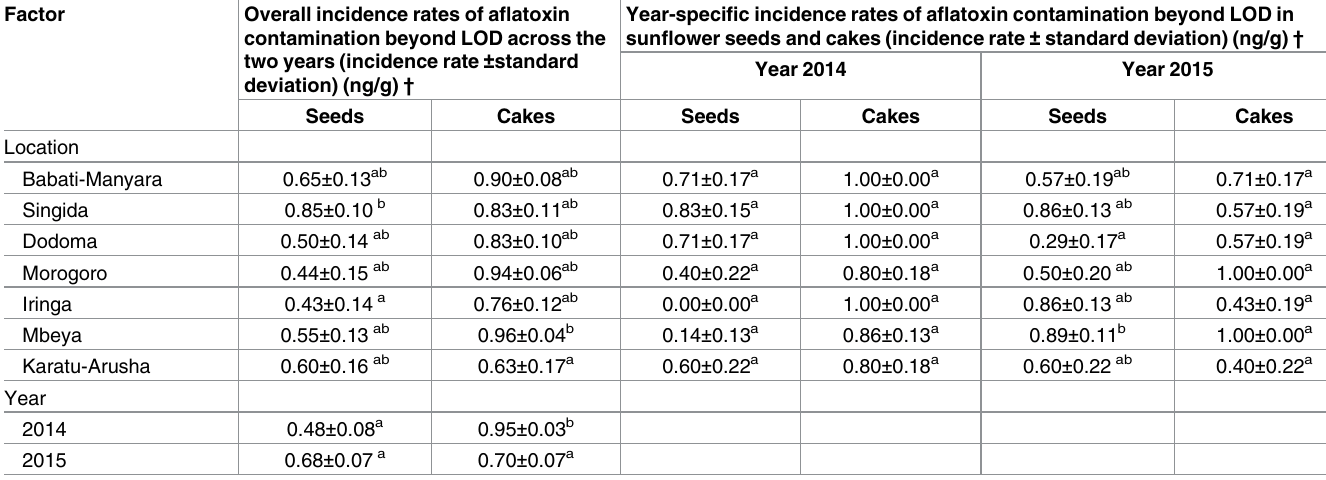
Table 6. Incidence rates of aflatoxin contamination for each location across and within the two yearsof 2014 and 2015. Factor Overall incidence rates of aflatoxin contamination beyond LOD across the two years (incidence rate ± standard deviation) (ng/g)